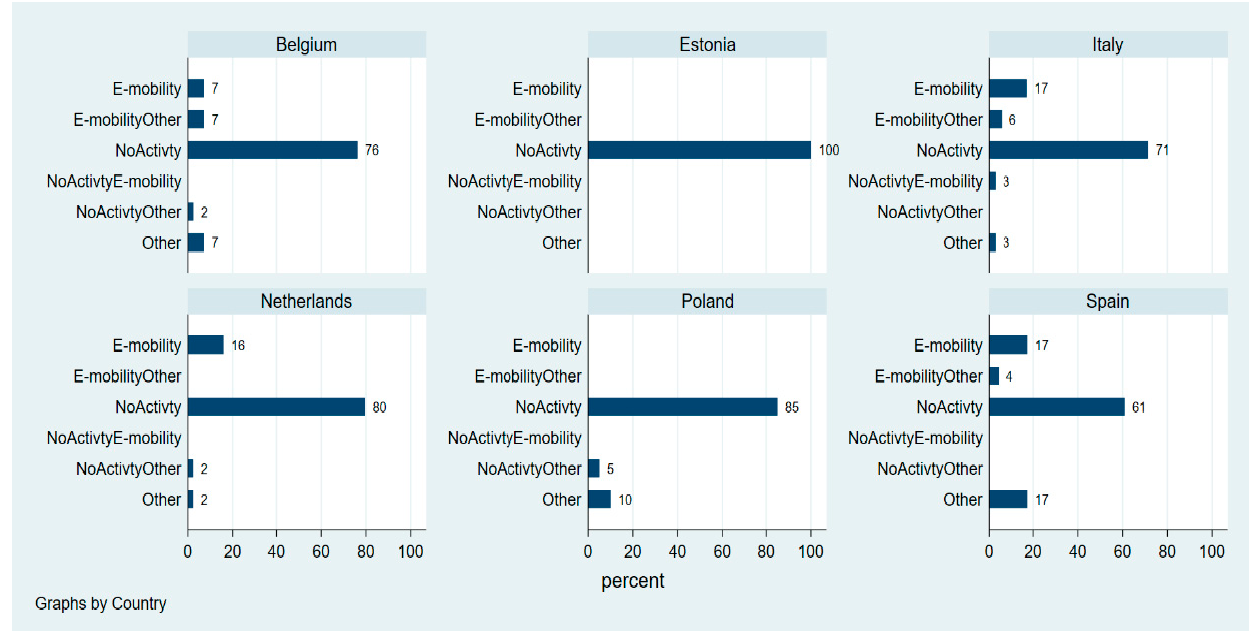
Figure A2. Renewable Energy Generation Combinations. Results in percentages.